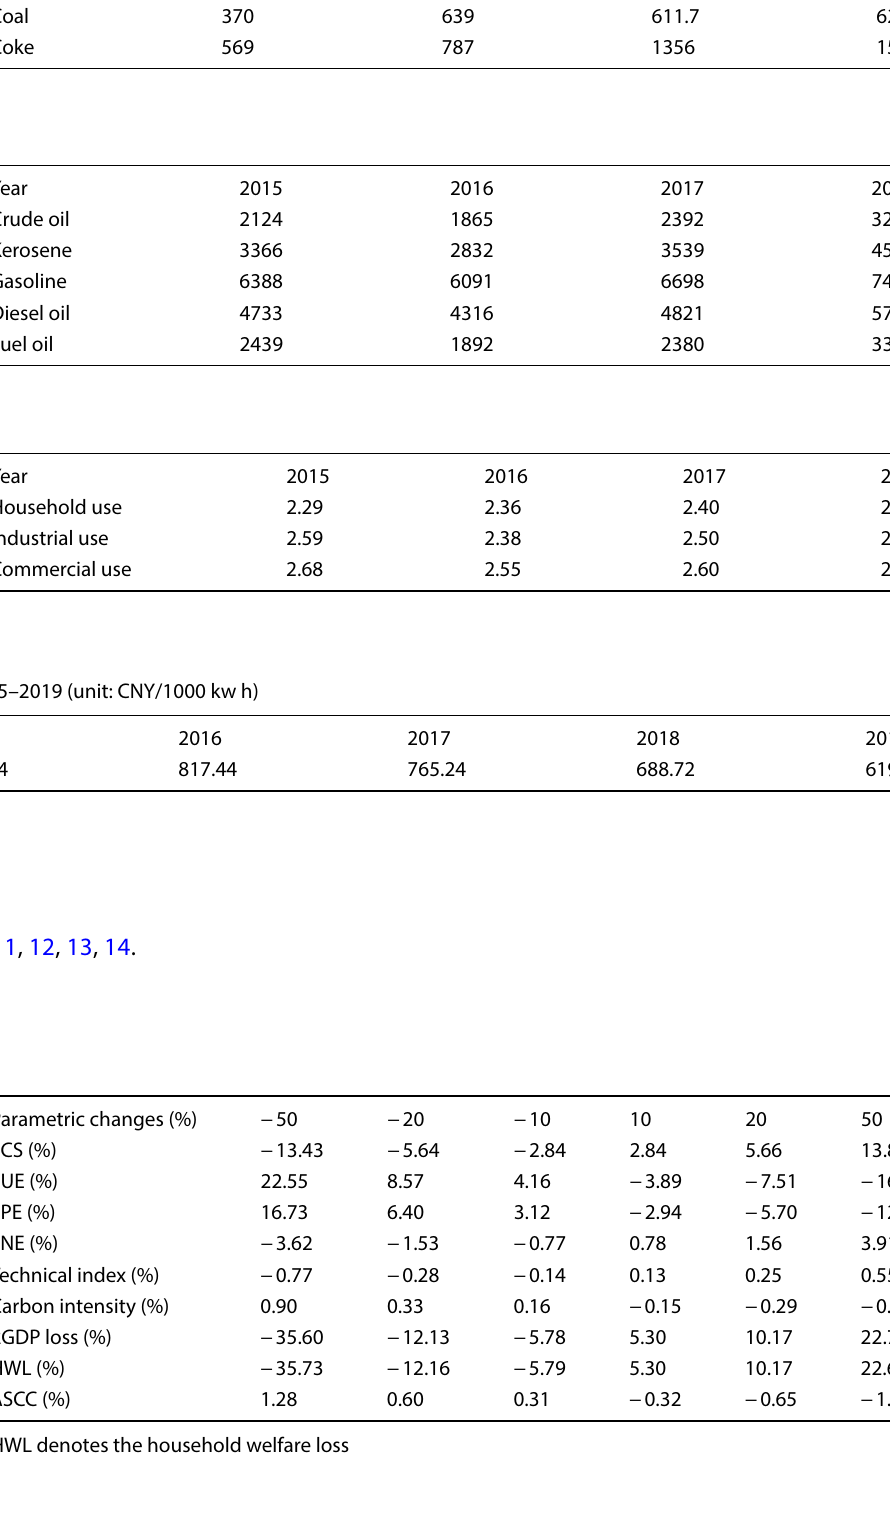
Table 4 The coal price and coke price in 2015–2018 (unit: CNY/tonne)